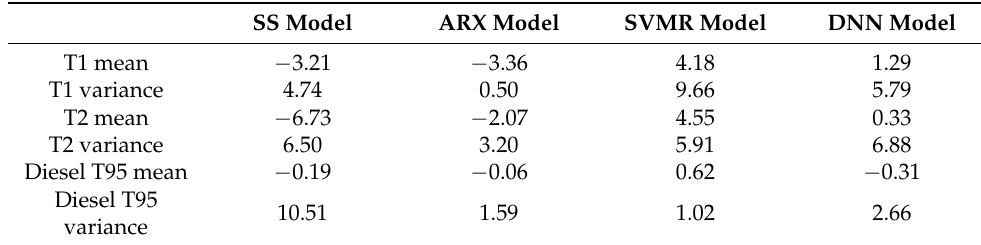
Table 2. Statistical information of the FFMPC